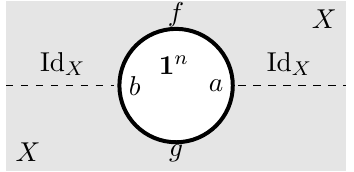
Figure 4 . Condensation completion of QL n